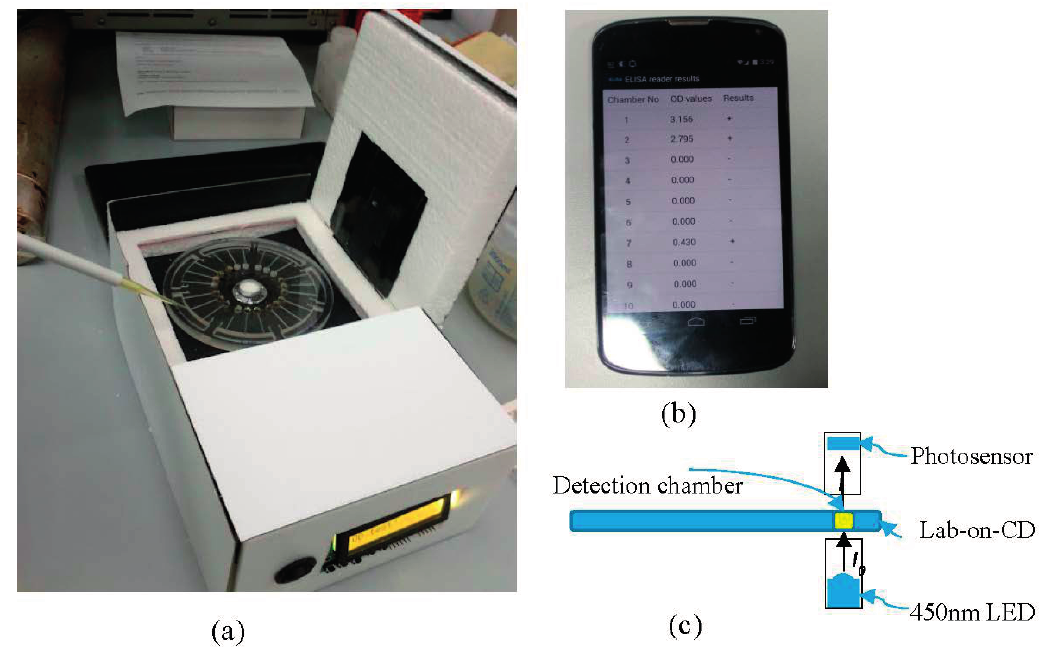
Figure 3. ( a ) Prototype of the LOCD ELISA reader; ( b ) Smartphone application displaying ELISA test results; ( c ) sensor operation principle in evaluating